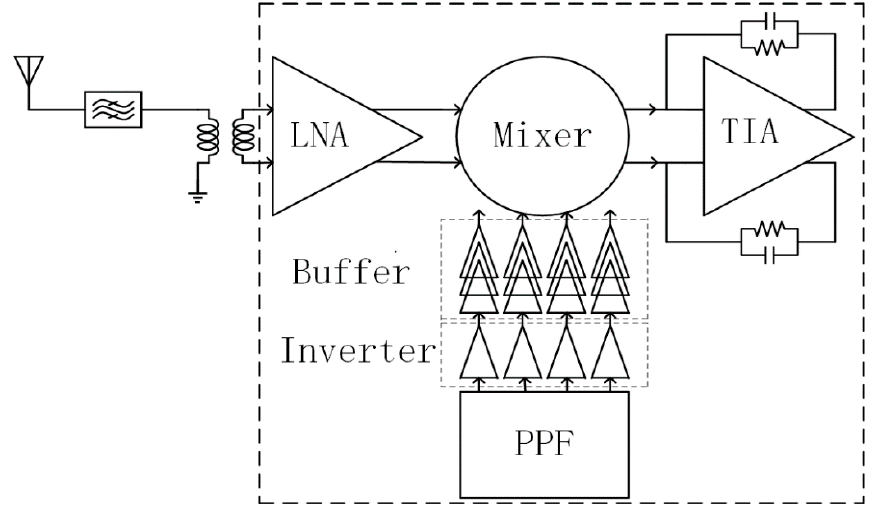
Figure 1. Block diagram of the proposed circuit.